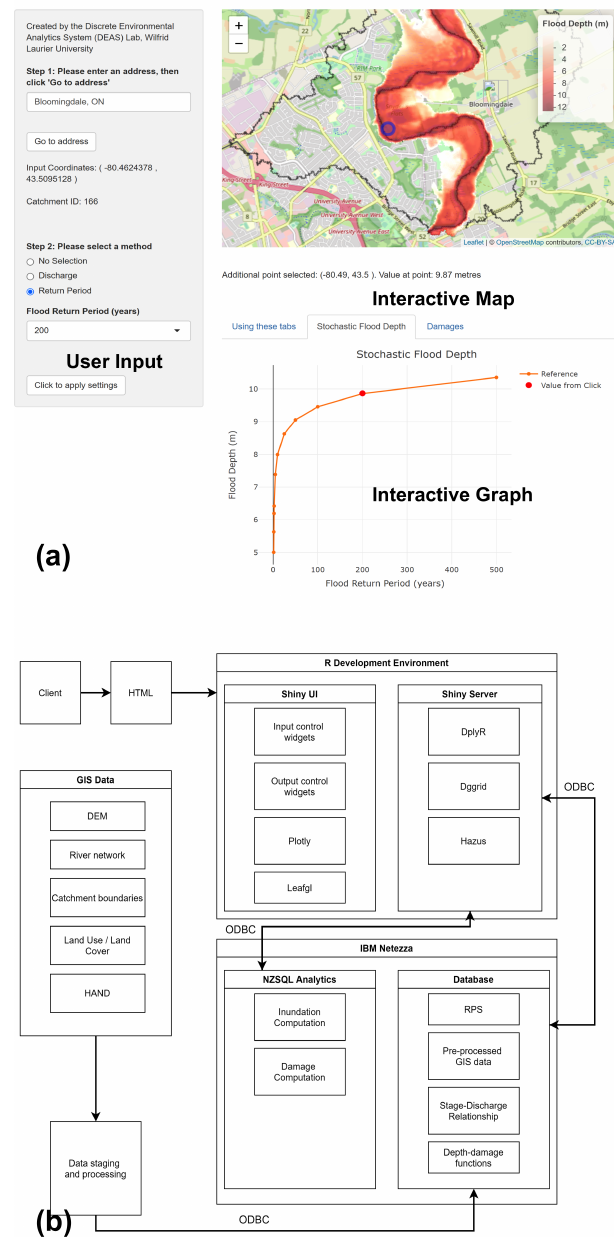
Figure 3. InundatEd user interface (a) and system diagram (b) . The basemap is created in Leaflet using © OpenStreetMap contributors 2020. Distributed under a Creative Commons BY-SA